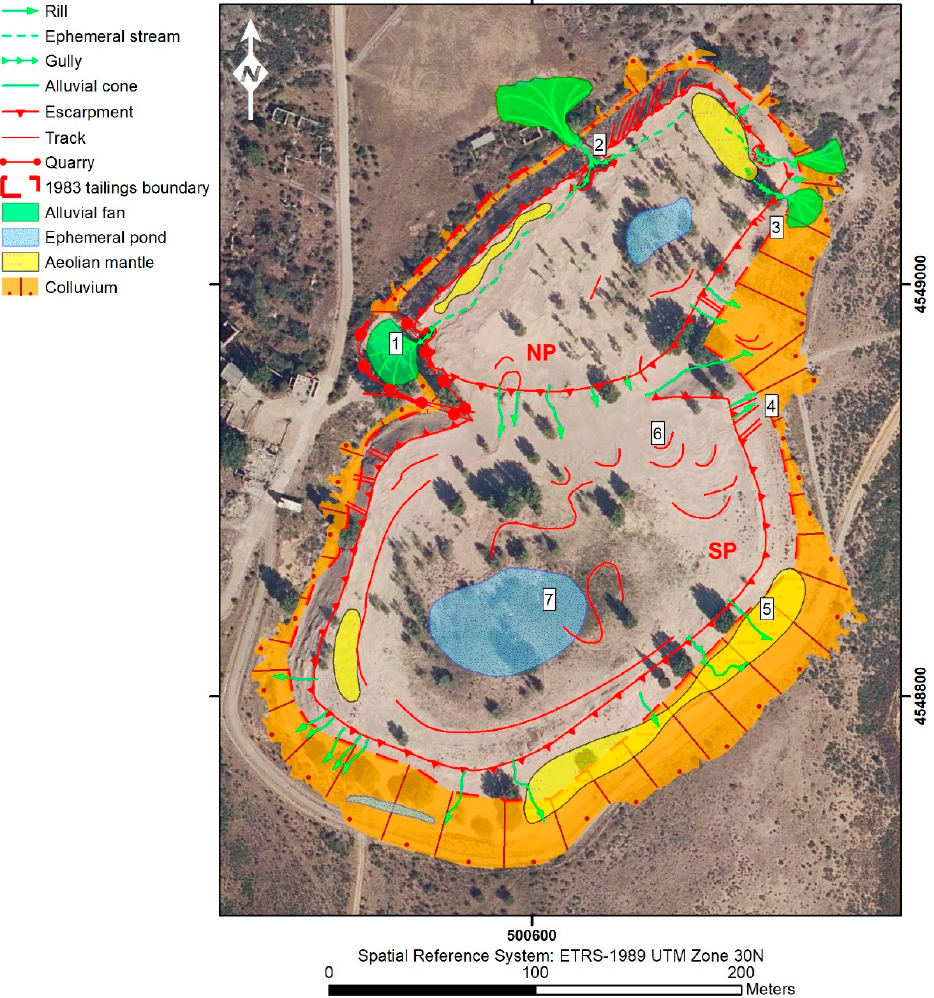
Figure 3. Geomorphological map based on the photointerpretation of the 2018 orthophoto and field observations. Numbers correspond to the shooting position of the photographs shown in Figure 4.